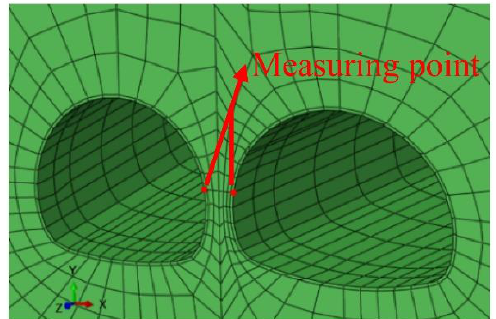
Figure 9. Layout of monitoring points of hance in the small clear-distance tunnel.